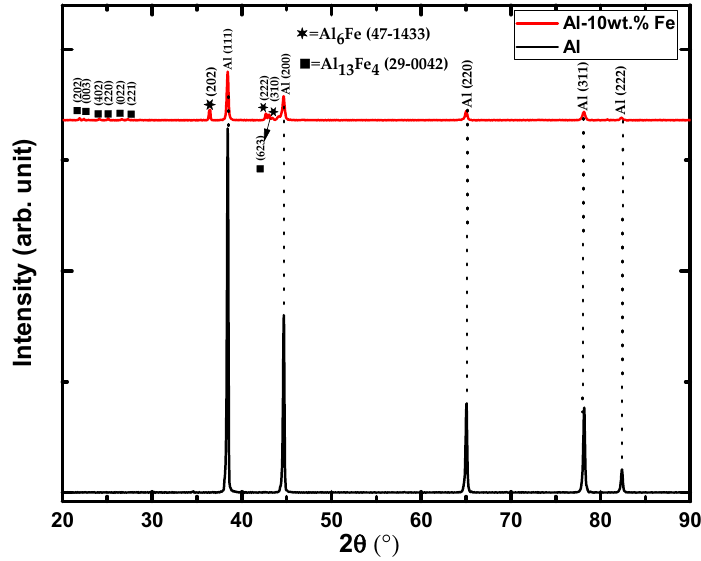
Figure 3. X-ray di ff raction (XRD) pattern for pure Al and Al-10 wt.% Fe after sintering. Figure 3. X-ray diffraction (XRD) pattern for pure Al and Al-10 wt.% Fe after sintering.